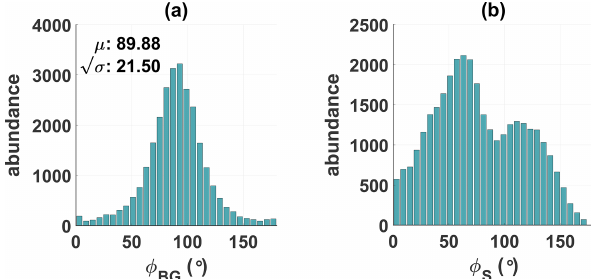
Figure 10. Histograms of the angle between the minimum variance direction and the background magnetic field (a) and the spacecraft- Sun connection line (b) . The waves propagate predominantly per- pendicular to the background field and at an angle ± 65 ◦ to the Sun.